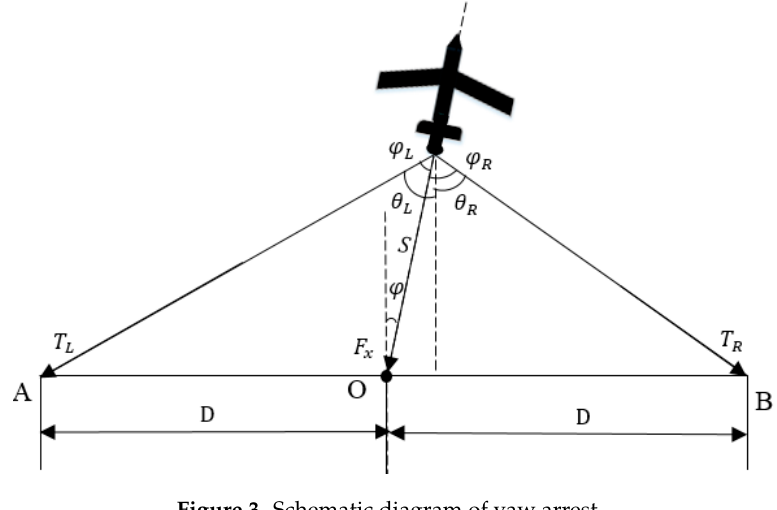
Figure 3. Schematic diagram of yaw arrest.